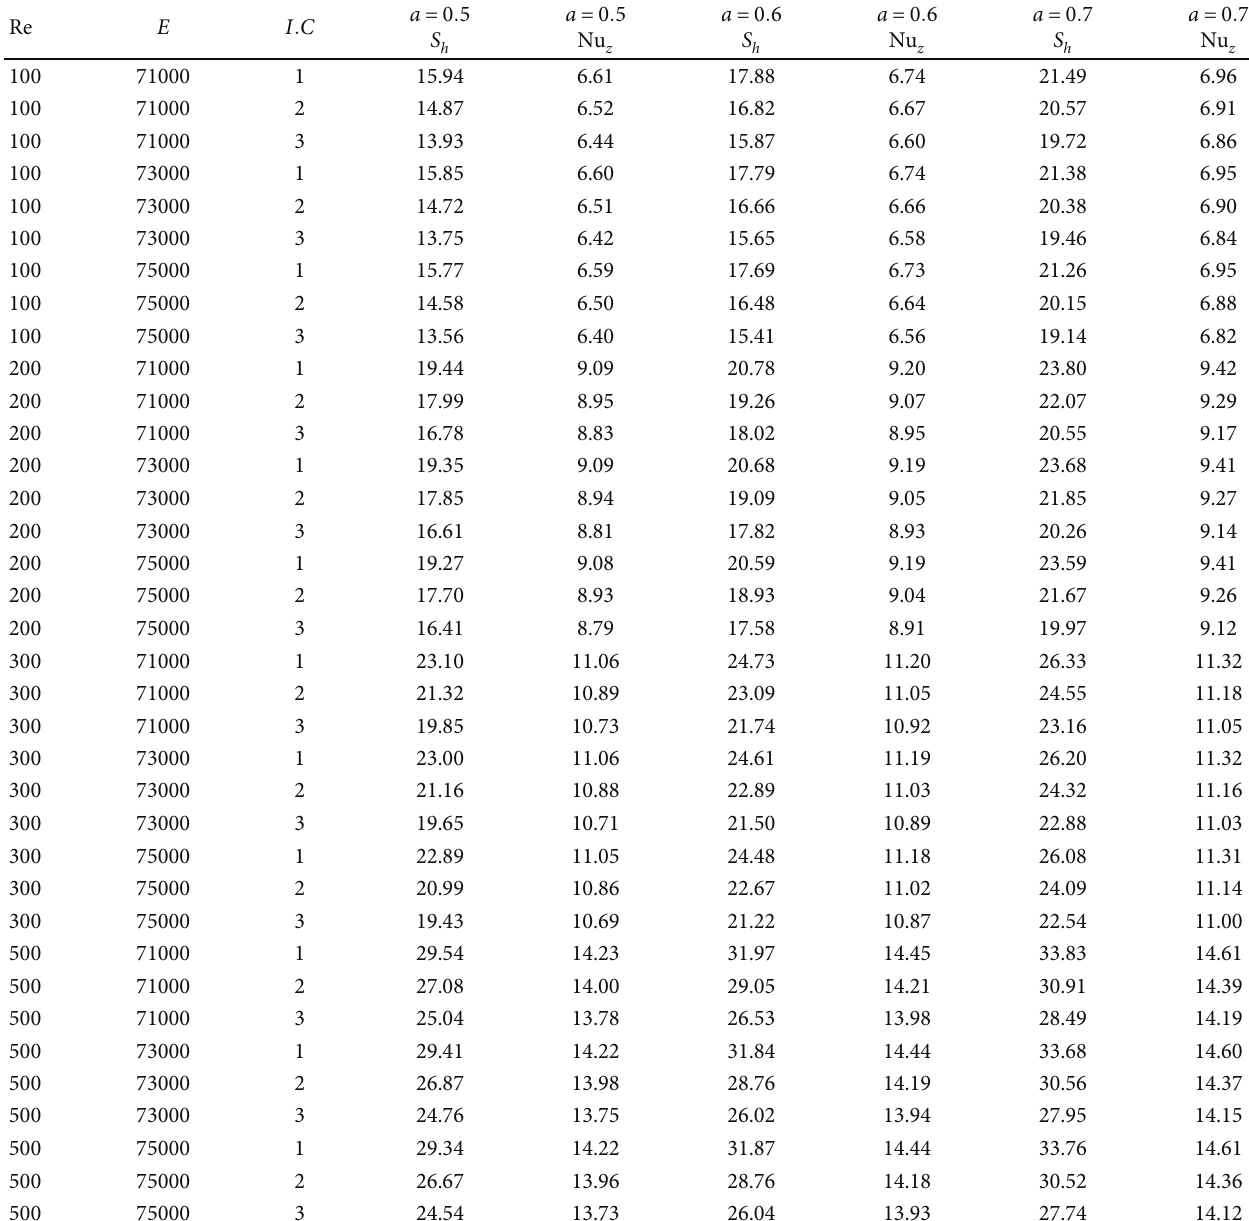
Table 2: Average Nusselt number at the outlet of the